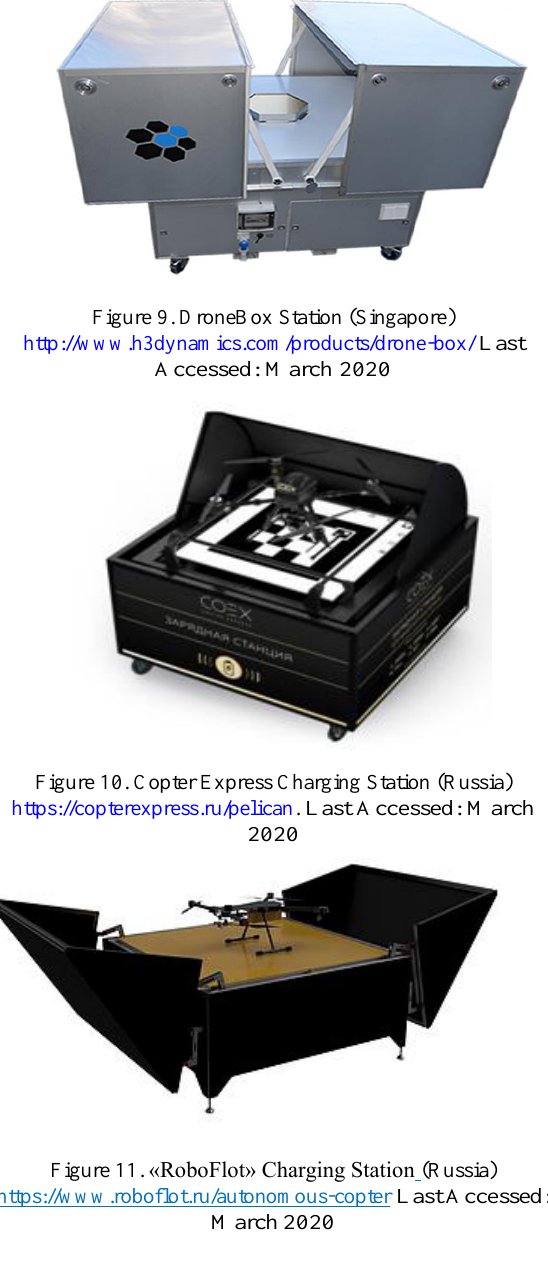
Figure 8. AzurDrones charging station (France) https://azurdrones.com/en/ Last Accessed: March 2020